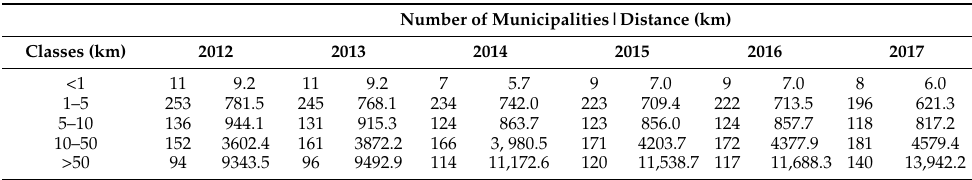
Table 3. Number of municipalities grouped in the distance classes from urban areas to MSW disposal sites by year and their total length.